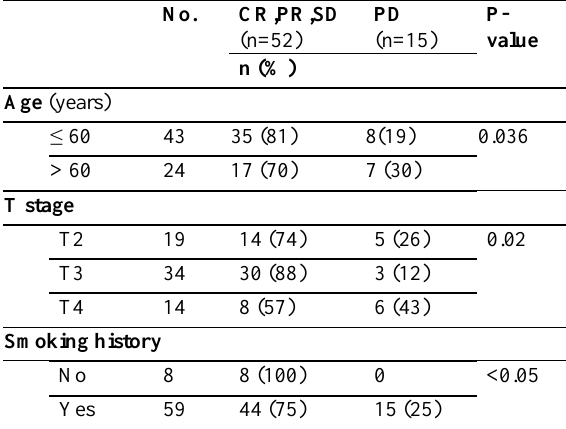
Table 2: Variables with significant correlation with the overall response